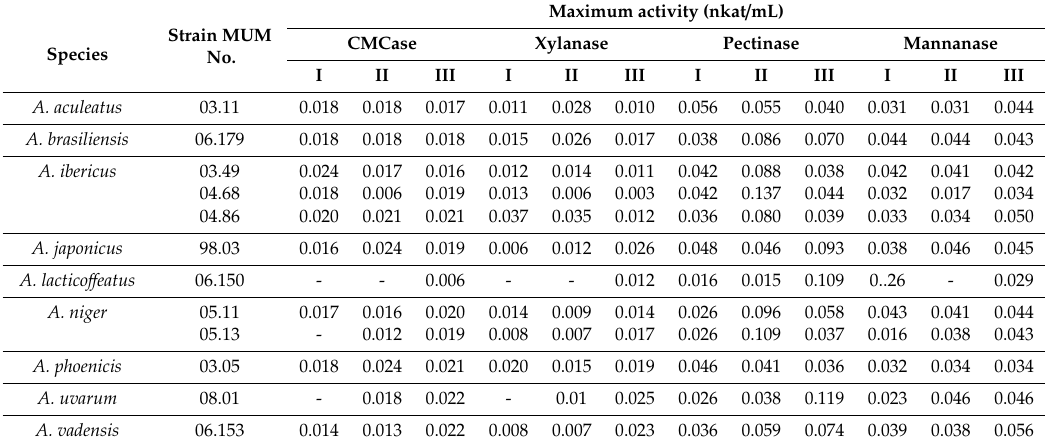
Table 4. Maximum polysaccharide-enzymatic activity detected during 7 days for supernatants of Aspergillus strains grown in maltose broth medium at di ff erent preservation time points (before (Time I), after 2 weeks (Time II) and 4 weeks (Time III) of